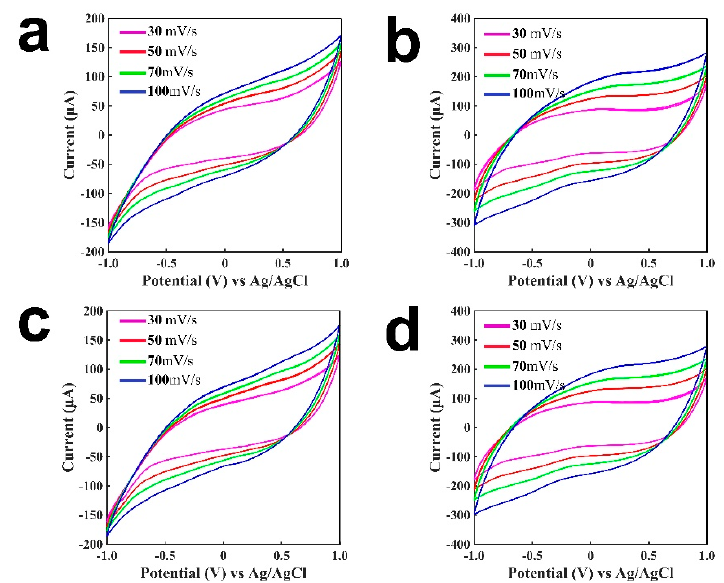
Figure 2. Cyclic voltammetry of the tongue-depressor amperometric sensors (from the second cycle). ( a ) A tongue depressor-based sensor without the immobilization of enzymes for buffer; ( b ) A tongue depressor-based sensor without the immobilization of enzymes for H 2 O 2 ; ( c ) A glucose oxidase (GOD)-immobilized tongue depressor-based sensor for buffer; ( d ) A GOD-immobilized tongue depressor-based sensor for glucose.